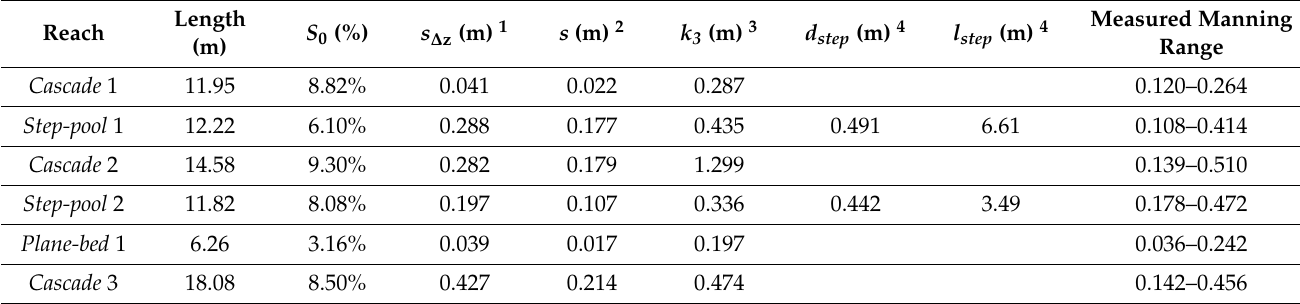
Table 2. Average geometry characteristics of the studied